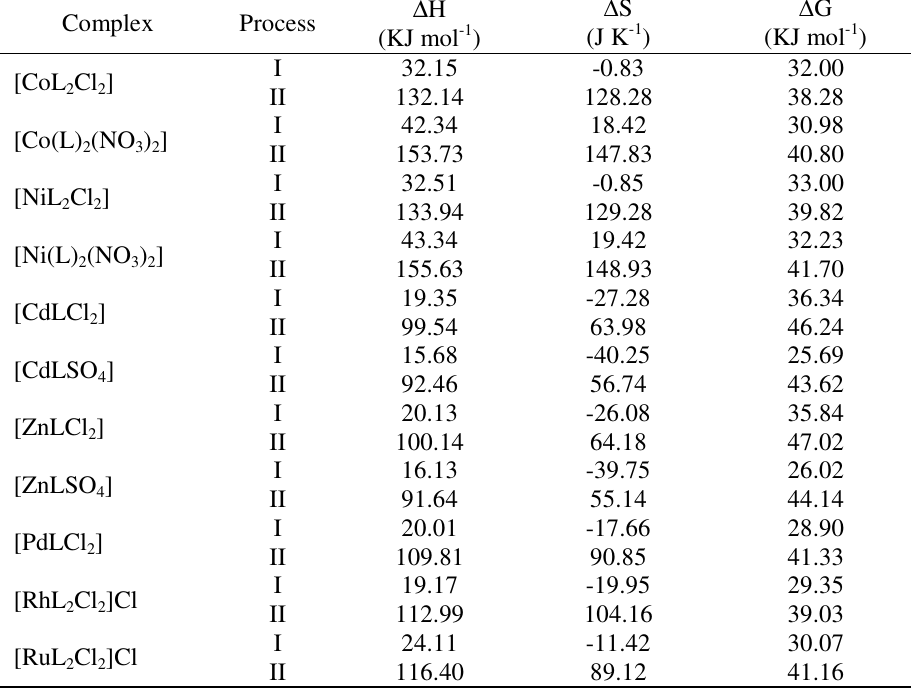
Table 5. Thermodynamic parameters for the thermal degradation of the complexes Complex Process